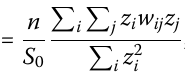
% of students % of people of schooling